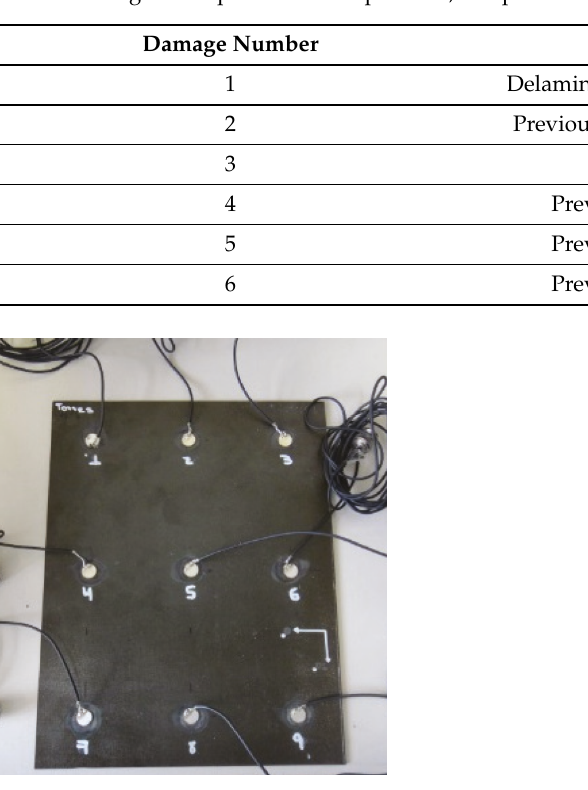
Table 4. Damage description in third specimen, composite material plate.